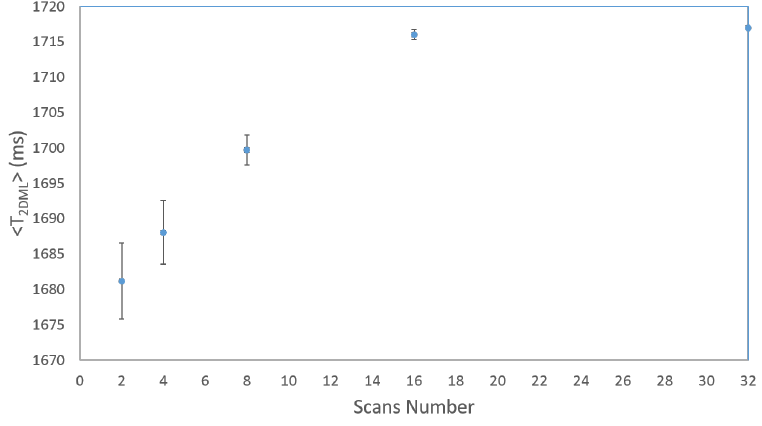
Figure 2. Average T 2 of the dominant peak location for water-wet glass beads in 1% Na 2 SO 4